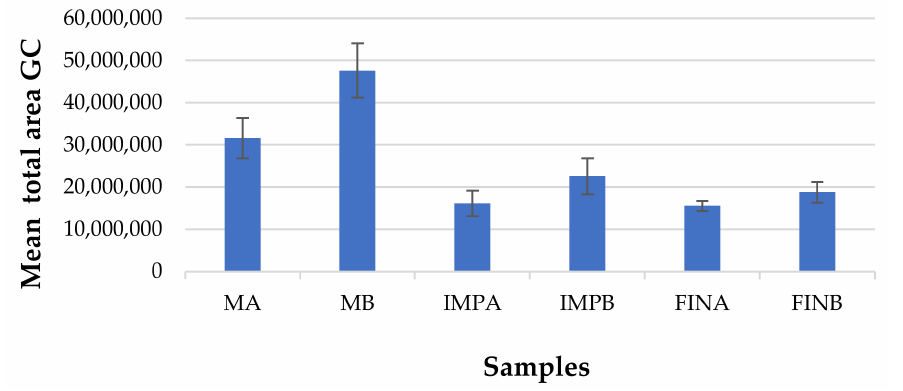
Figure 6. Mean total chromatographic area of the identified volatile organic compounds (VOCs) in sourdoughs and dough samples A and B.